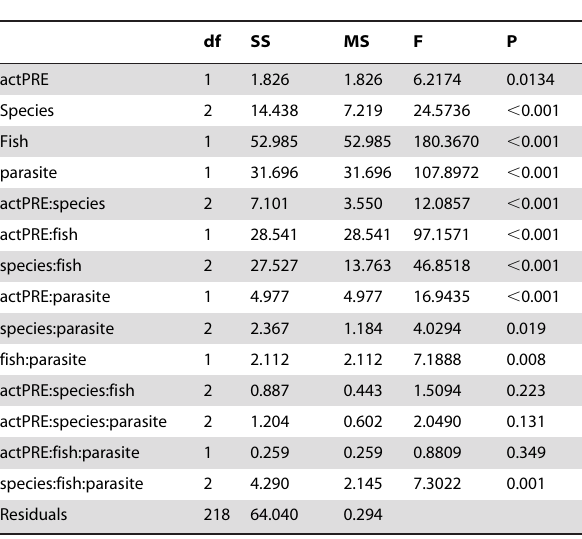
Table 1. Analysis of variance table for final model estimating post-treatment time active in tadpoles in response to effect